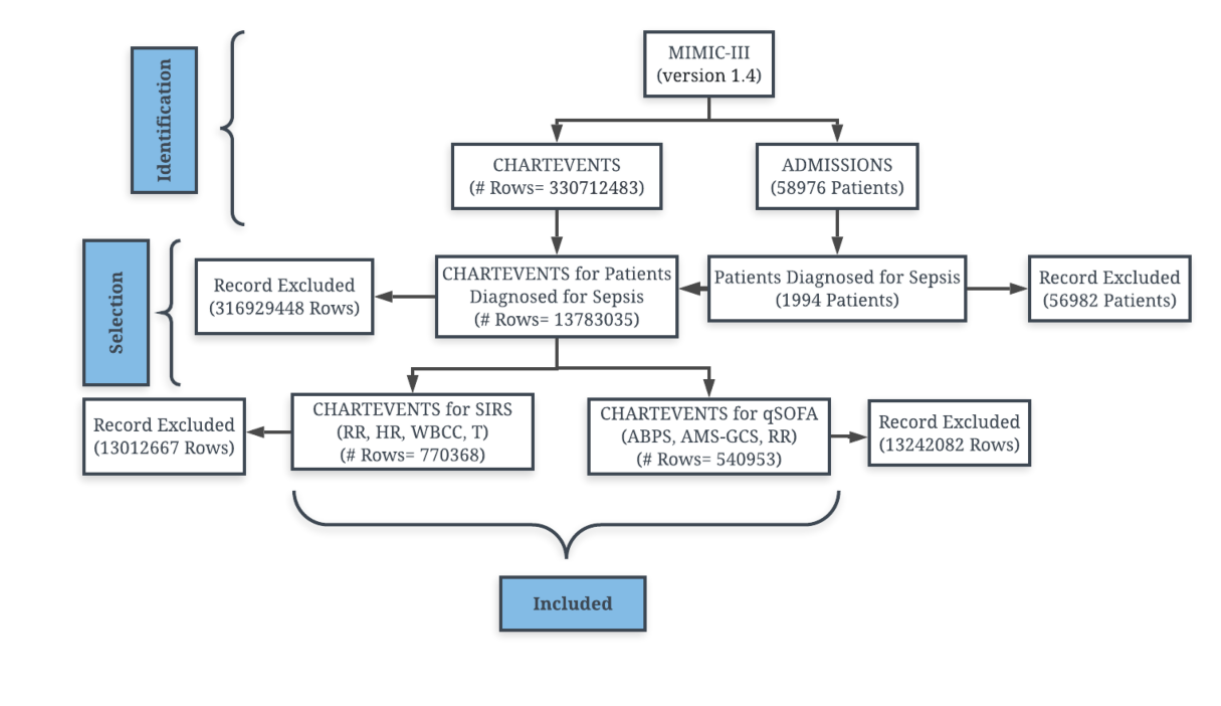
Figure 1. Outline of research